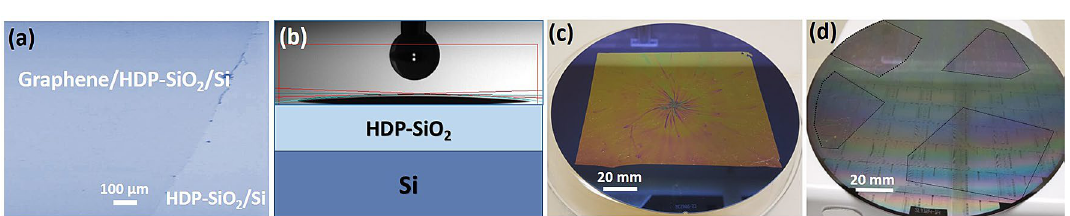
Figure 7. Schematic representation of possible surface modification after oxygen plasma and exposure to ambient.